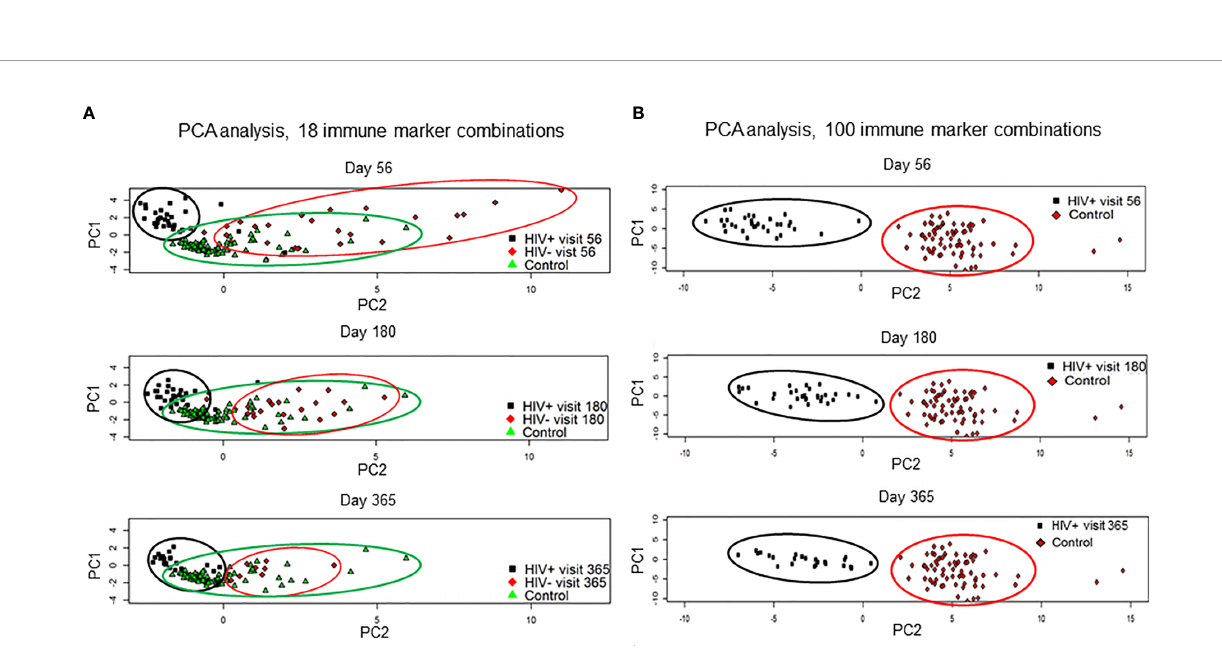
FIGURE 3 | Results of the principal component analysis by visits at day 56, 180 and 365. (A) HIV(+) AHCT recipient, HIV(-) AHCT recipient and healthy control lymphocyte populations were compared across 18 immune marker combinations at days 56, 180 and 365 post-transplant. (B) HIV(+) and healthy control lymphocyte populations were compared across 100 immune marker combinations at days 56, 180 and 365